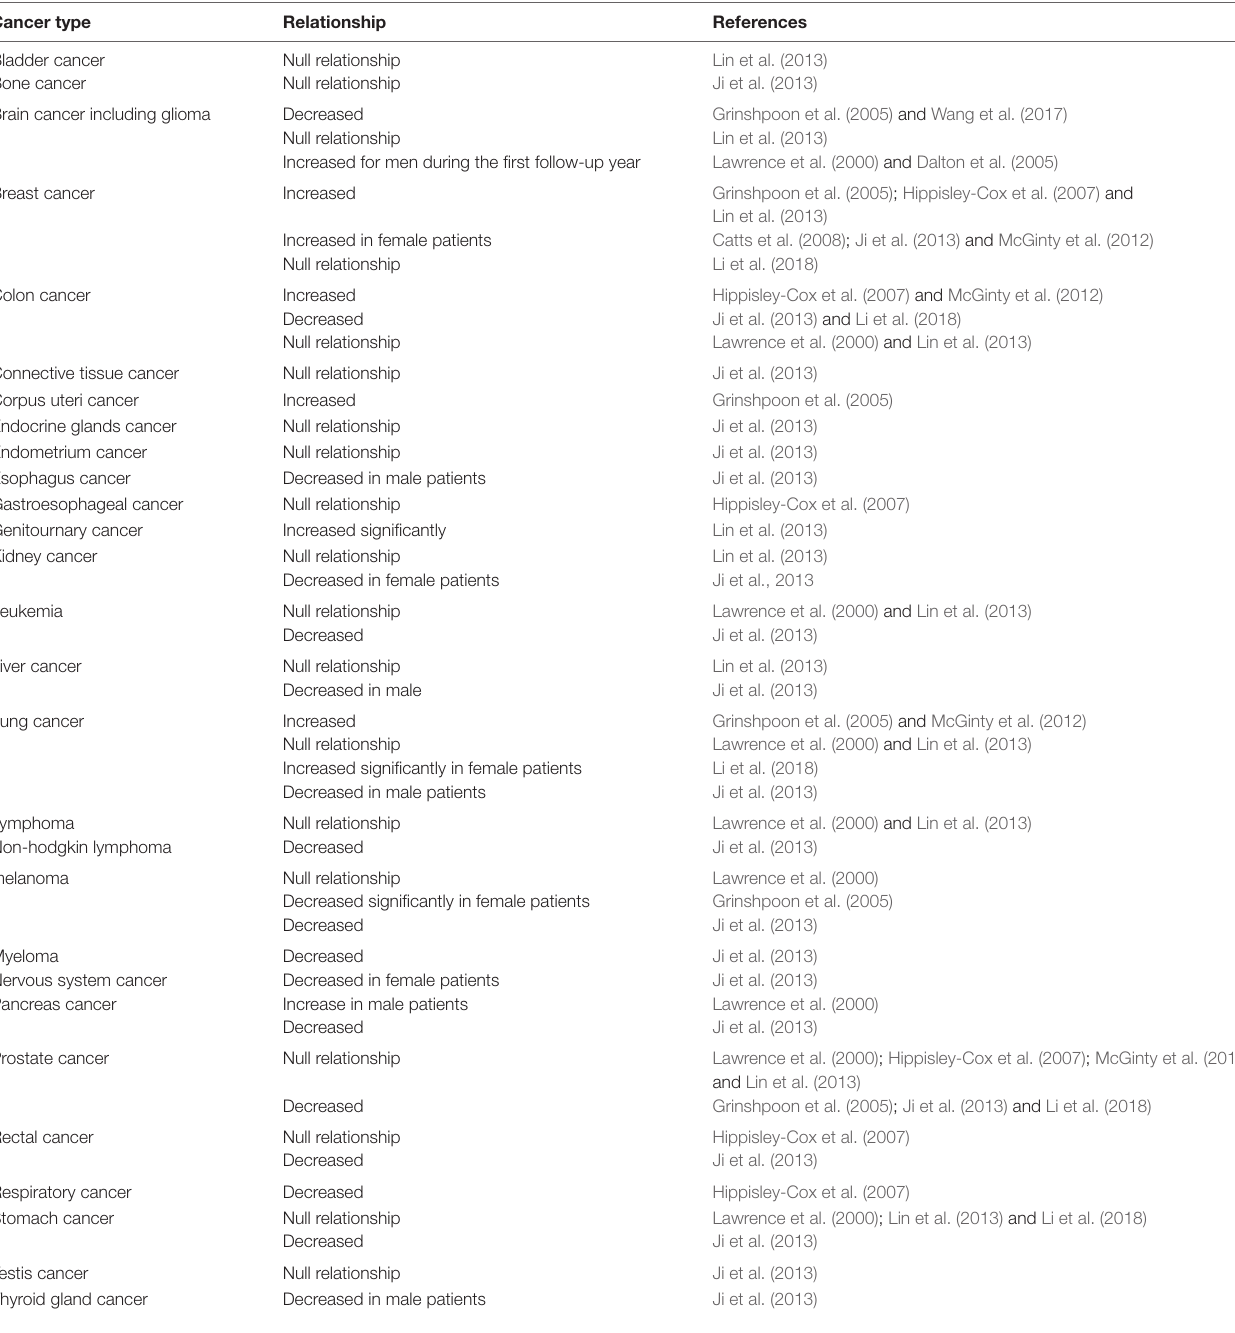
TABLE 1 | Summary of the relationship between the cancer risk and